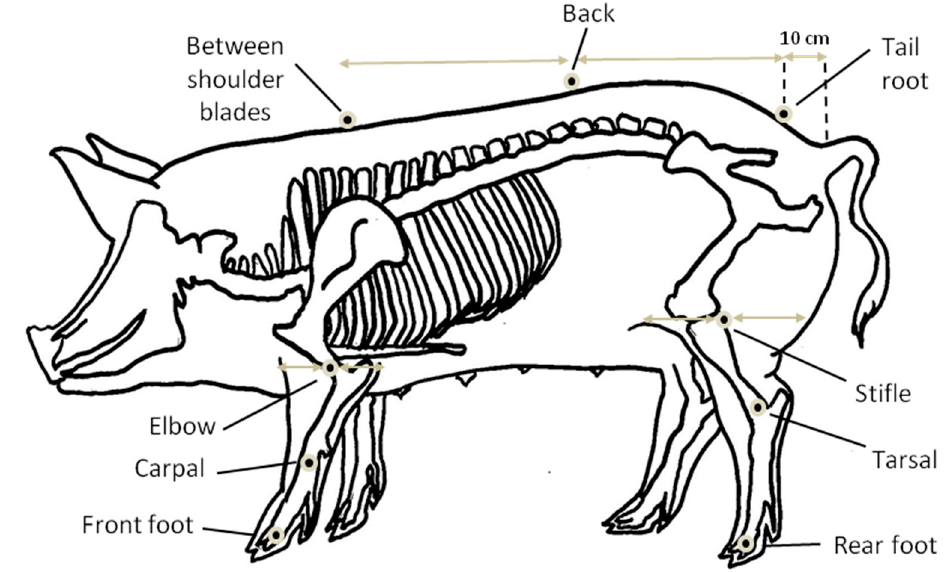
Figure 2. Positions of the nine reflective markers on the sow (three on each leg and three on the back) for the kinematics (feet markers are placed just below the coronary band; carpal and tarsal markers are placed on the radio-carpal and tibio-tarsal joints, respectively; elbow marker is in the middle of the fore leg sides at the elbow joint level; stifle marker is in the middle of the hind leg sides at the stifle joint level; and the back marker is exactly in between the shoulder blades and tail root markers [25]).